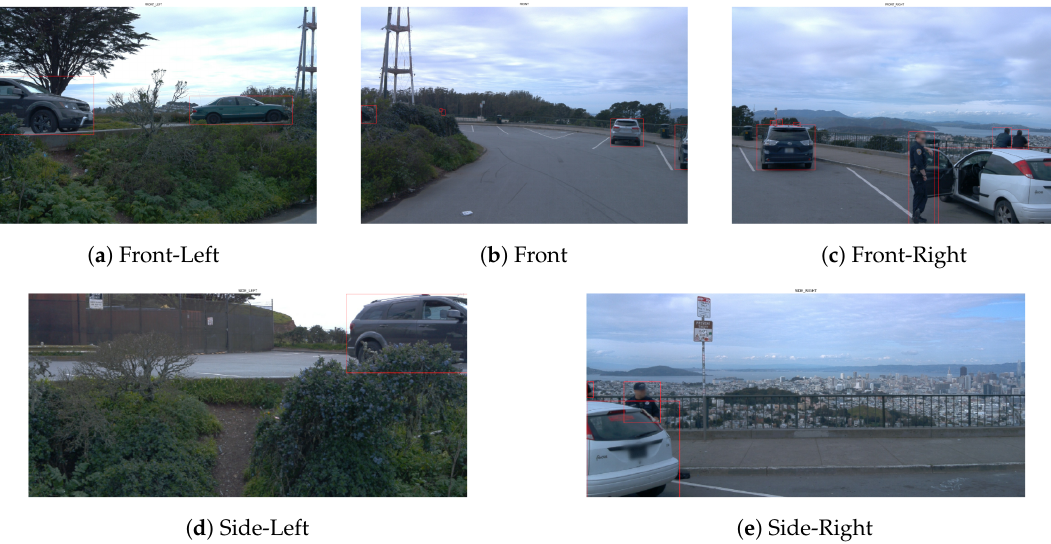
Figure 2. One example of images captured by cameras of five different views from segment- 11004685739714500220 of tar training_0000 in the Waymo Open